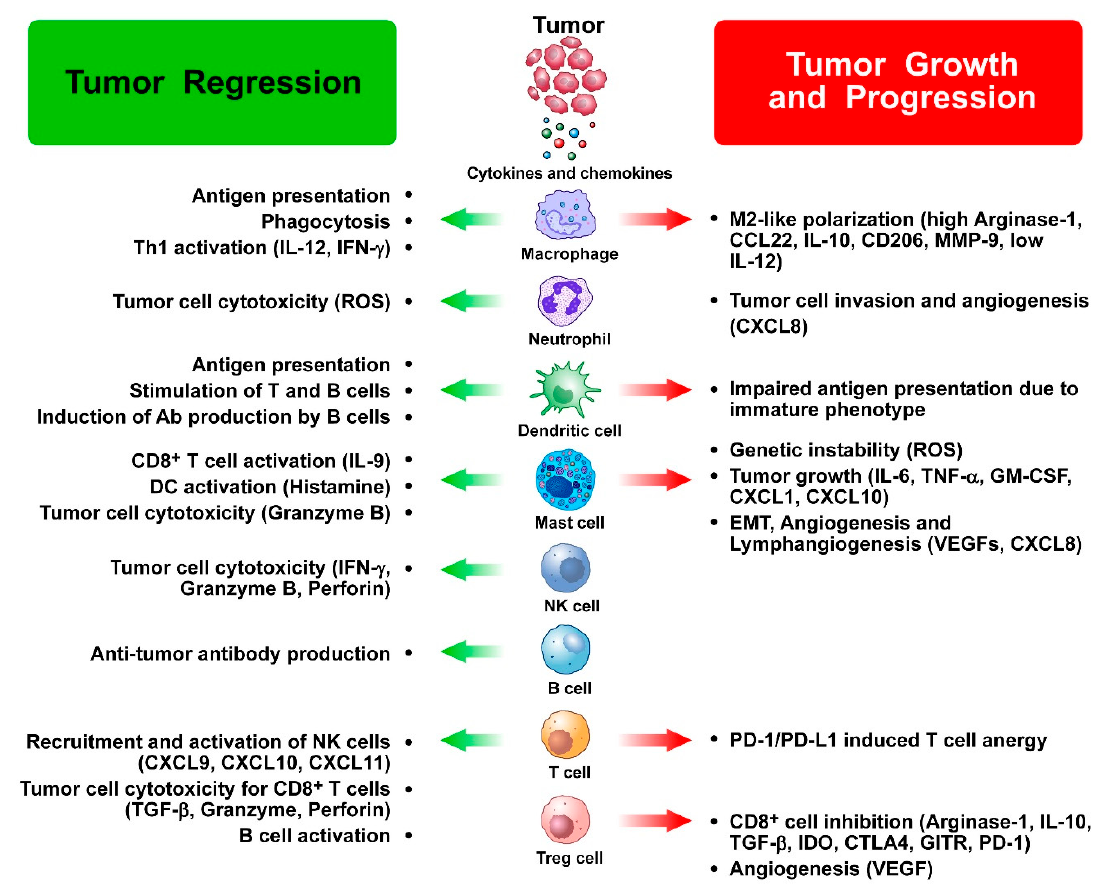
Figure 1. Dual role of immune cells in thyroid cancer growth and progression. Tumor-infiltrating immune cells can exert both antitumor and protumor functions in thyroid cancer and interact with each other as well as with cancer cells. A number of soluble factors (cytokines, chemokines, angiogenic and lymphangiogenic factors) released by immune cells mediate the protumor as well as the antitumor effects of immune cells in thyroid cancer (see text for details). List of abbreviations: Ab: antibodies; CTLA-4: Cytotoxic T-lymphocyte antigen 4; DC: dendritic cell; EMT: epithelial-to- mesenchymal transition; GITR: glucocorticoid-induced tumor necrosis factor family receptor; IDO: